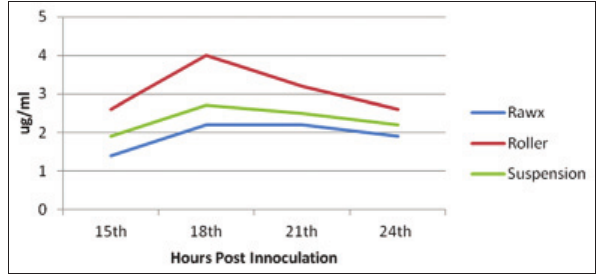
Figure-5: Effect of cell culture system on foot and mouth disease virus serotype (O) antigenicity (146S content) in baby hamster kidney-21 cell culture at 37°C.